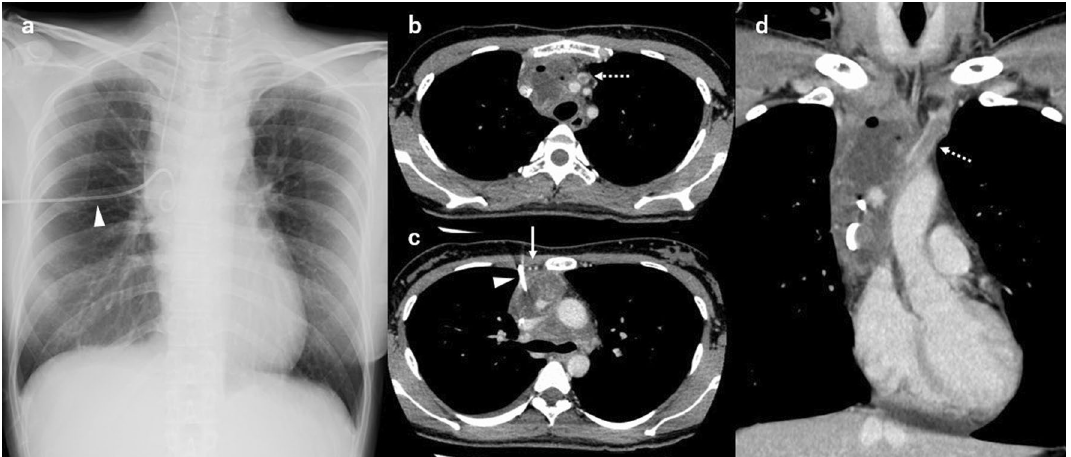
Fig. 3 Chest X-ray image ( a ) and contrast-enhanced CT findings ( b – d ) after extubation. The image b is at the trachea level. The image c is at the level of carina of the trachea. The image d is the coronal section. The pigtail catheter (white arrowhead) was inserted laterally into the right internal thoracic artery and vein (white arrow). The left brachiocephalic vein (dotted white arrow) was surrounded by the tumor and